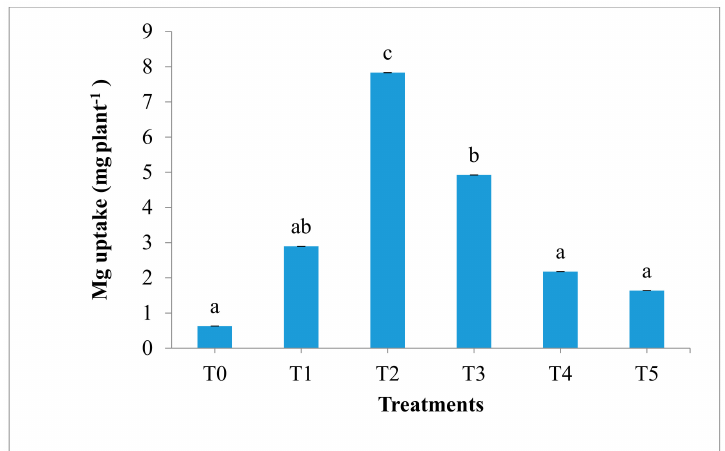
Figure 8. Effects of treatments on total Mg uptake at harvest (70 DAT). Mean values with different letter(s) indicate significant difference between treatments by Tukey’s test at p ≤ 0.05. Bars represent the mean values ± SE. Table 12. Effects of RSRH biochar on N, P, and K use efficiency at harvest (70 DAT).